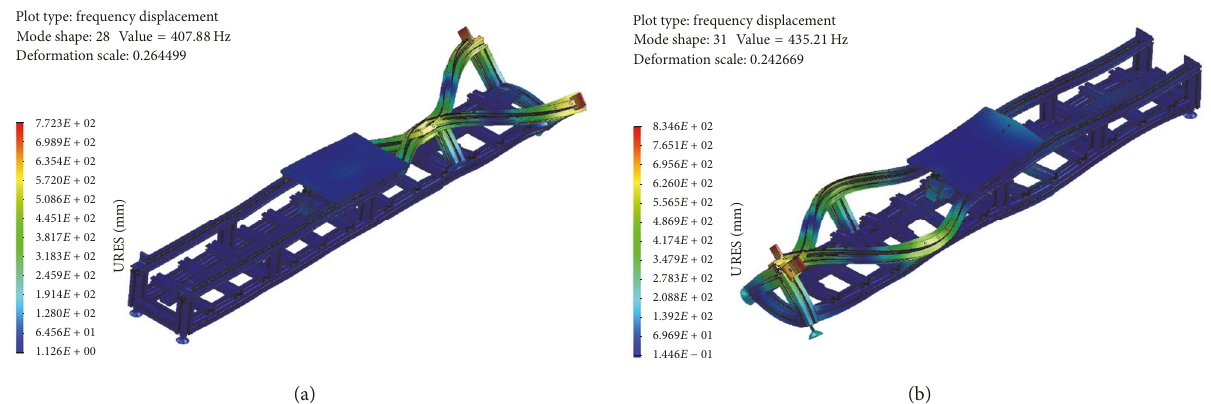
Figure 18: Shapes for second-order modes with transversal waves at the top lateral bars at position P3: (a) mode 28 ( 𝑓 ≈ 407 Hz, def. scale ≈ 0.265); (b) mode 31 ( 𝑓 ≈ 435 Hz, def. scale ≈ 0.243).